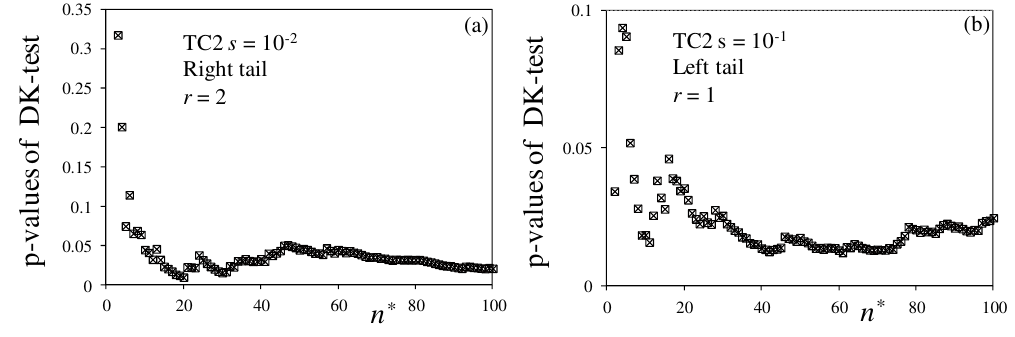
Fig. 10. DK test p values for TC2 and (a) r = 2 at s = 10 − 2 and (b) r = 1 at s = 10 − 1 .